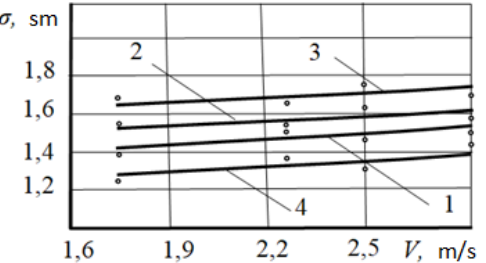
Figure 6. Influence of the speed of movement of the unit and the technological scheme of the tool on the standard deviation of the working depth (Background - fallow)